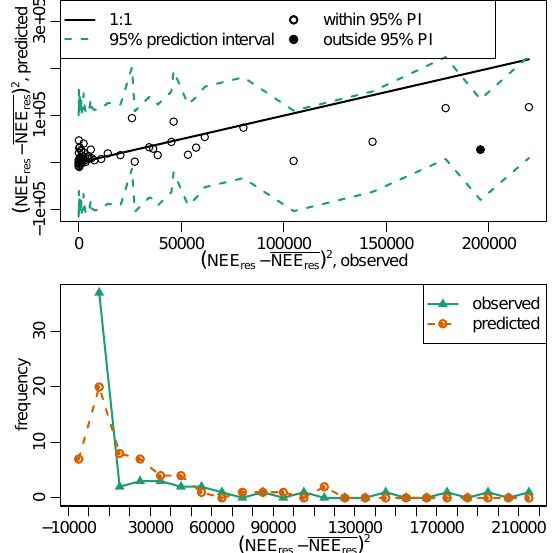
Fig. 13. Results from an empirical regression model (Eq. 5) for VPRM NEE residual spread. Units are (gCm − 2 yr − 1 ) 2 . Top panel shows observed values vs. predicted values at 27 cross-validation sites (Table 2). Observed values are outside of the 95% prediction interval where the solid line falls outside of the dashed lines. One of 56 predicted values (2%) is outside the 95% prediction inter- val. The bottom panel shows histograms for observed values and model-predicted values.